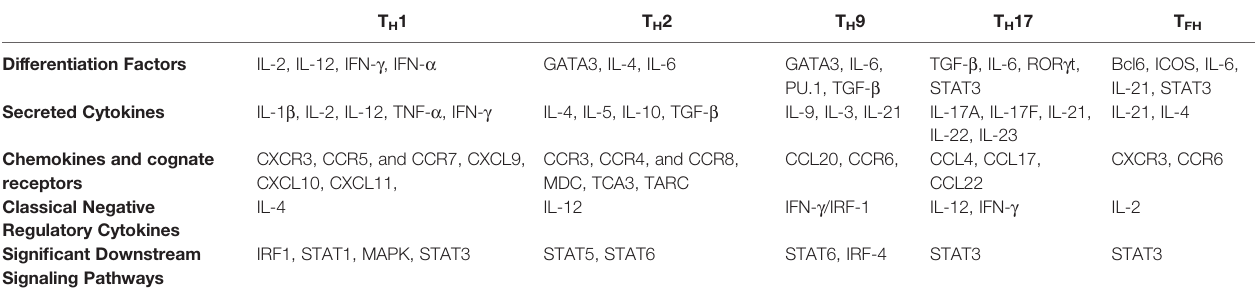
TABLE 1 | Role of cytokines and chemokines in TH cell